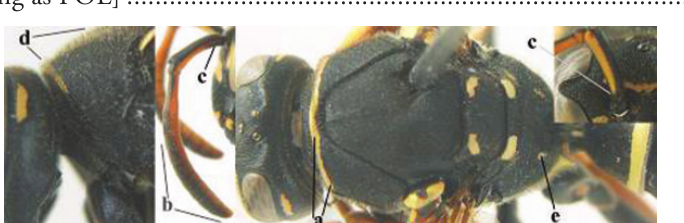
16 Transverse yellow band of pronotum narrow (a); antenna largely black or blackish dorsally (b), similar to colour of frons; basal third of scapus more or less black or blackish ventrally (c); pubescence of pronotum and mes- oscutum 0.7–0.9 times as long as diameter of anterior ocellus (d); yellow spots of propodeum narrow or absent, if present then usually narrower than minimum distance between spots (e); [malar space at least 0.87 times as long as POL] ........................................................................................ 17